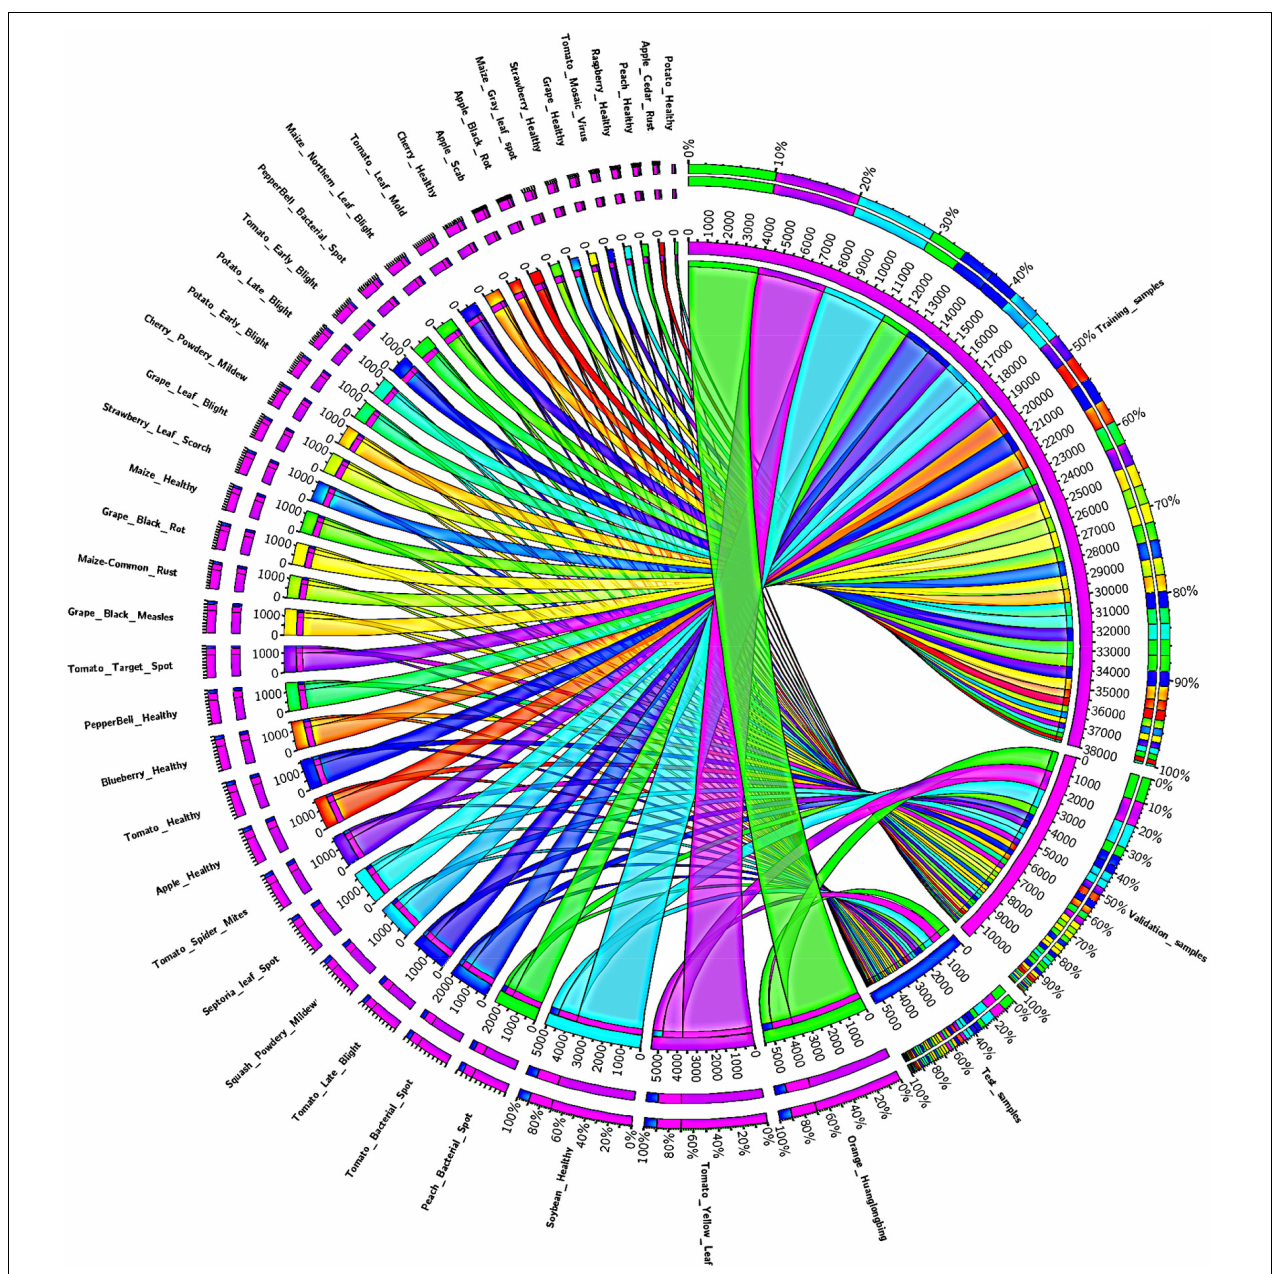
FIGURE 1 | Class-wise detailed description of the PlantVillage